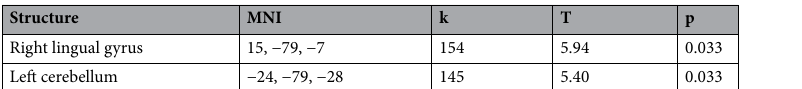
Table 4. fMRI results of ES > MS for the contrast correct rejection of lure > false alarms in the retrieval phase (p < 0.05, FDR corrected on the cluster level).